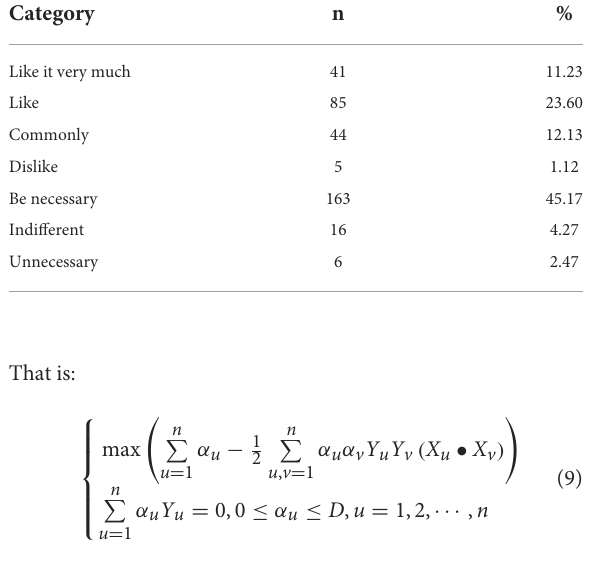
TABLE 1 Statistical list of attitudes of disabled persons toward physical exercise.